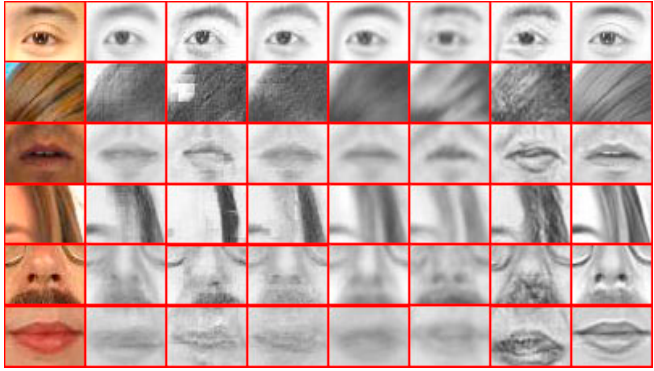
Figure 4. Local cut-out effect on Figure 3; same marshalling sequence as Figure 3.